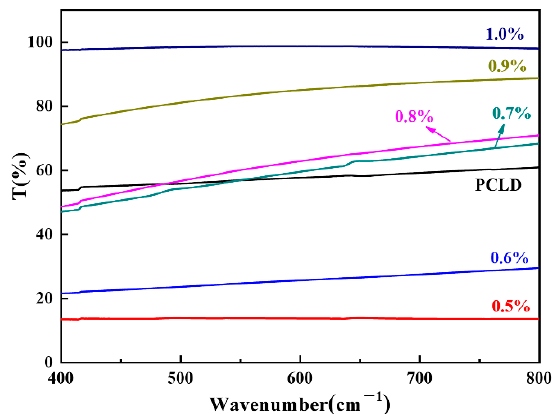
Figure 4. Digital images of leather coated by WPU-A with different AAS contents.